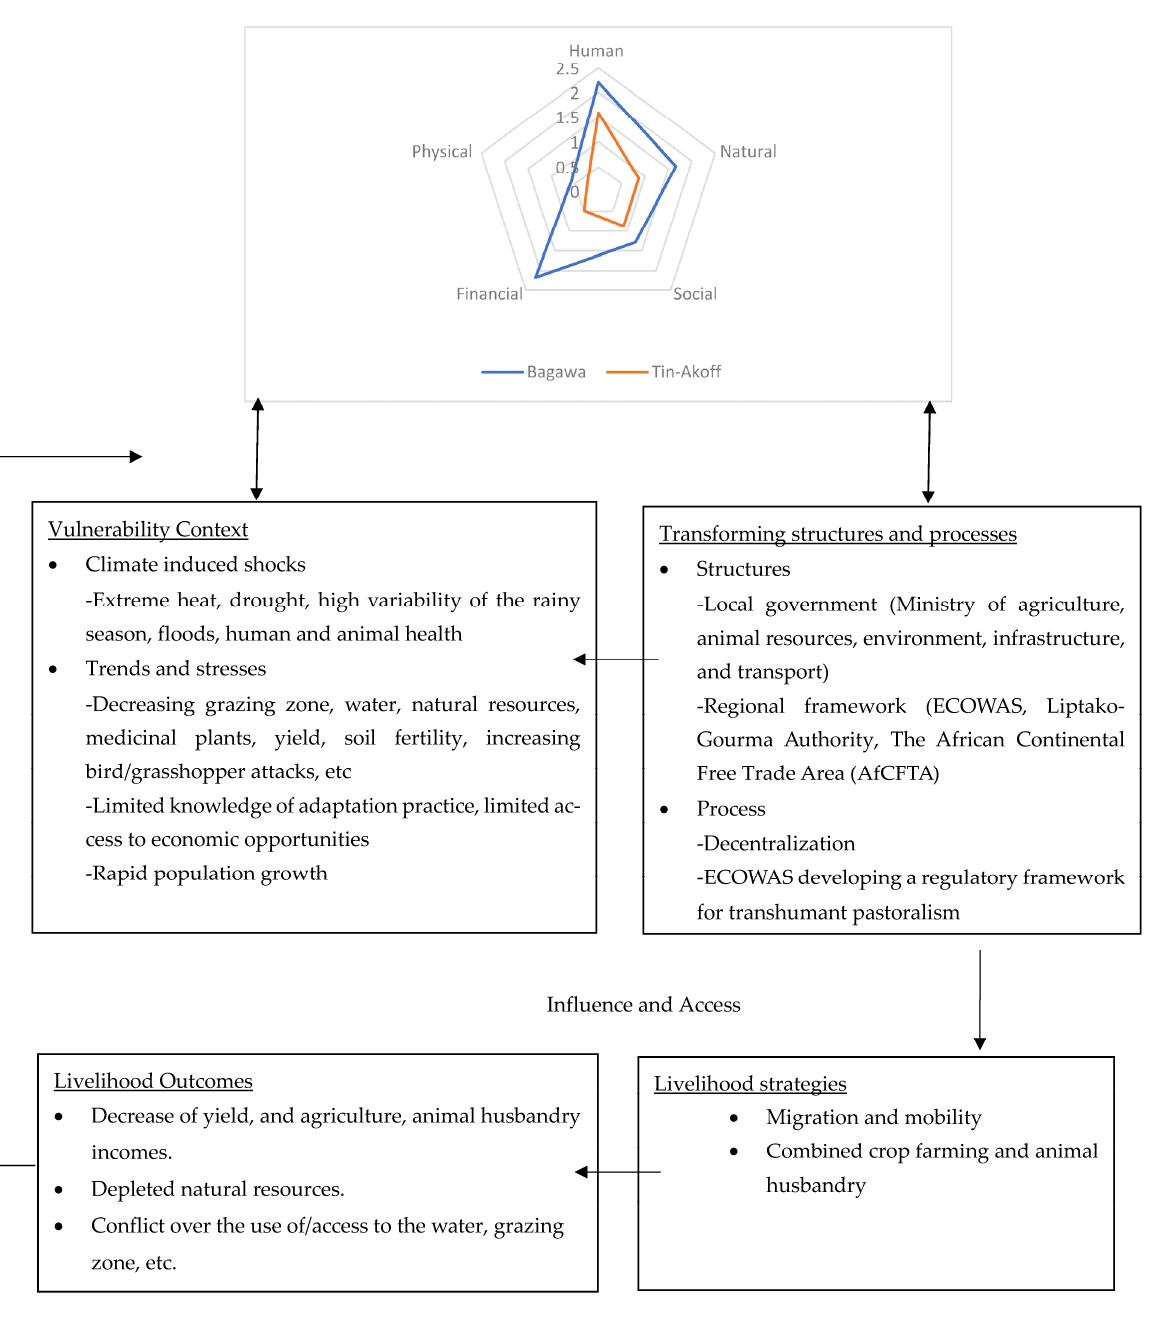
Figure 2. Livelihood Assets.